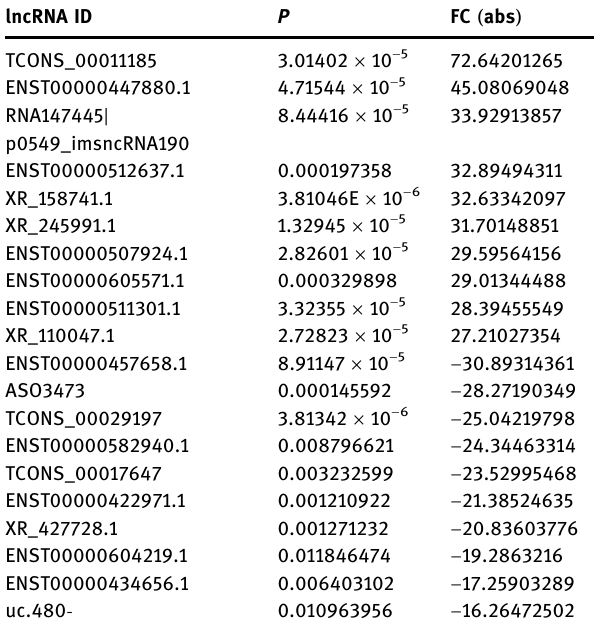
Table 3: The most up - regulated and down - regulated